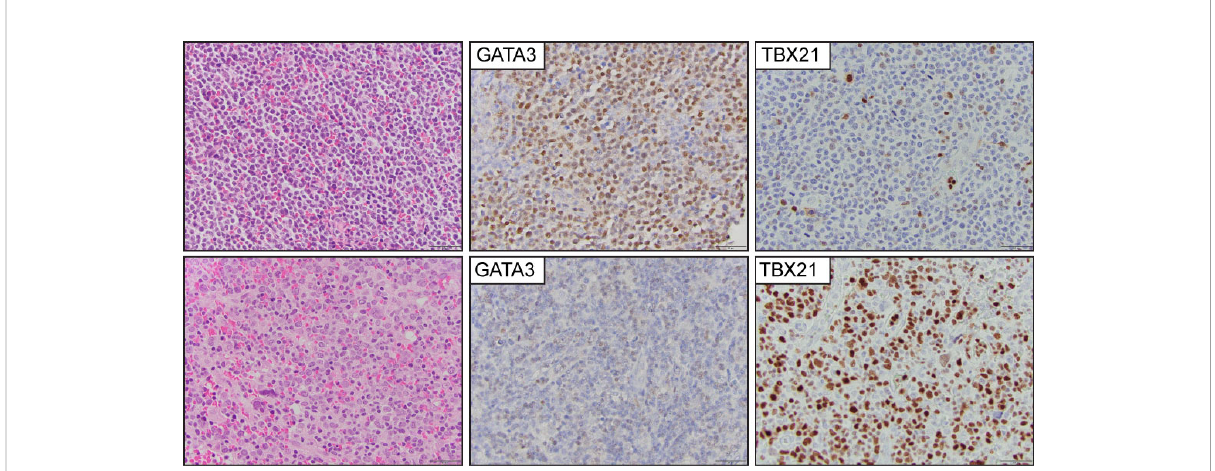
FIGURE 7 Peripheral T-cell lymphoma, non-otherwise speci fi ed (PTCL-NOS). Representative images from two PTCL-NOS cases. The upper panel shows a case classi fi ed in the GATA3 positive group, and (the lower panel) highlights a case within the TBX21